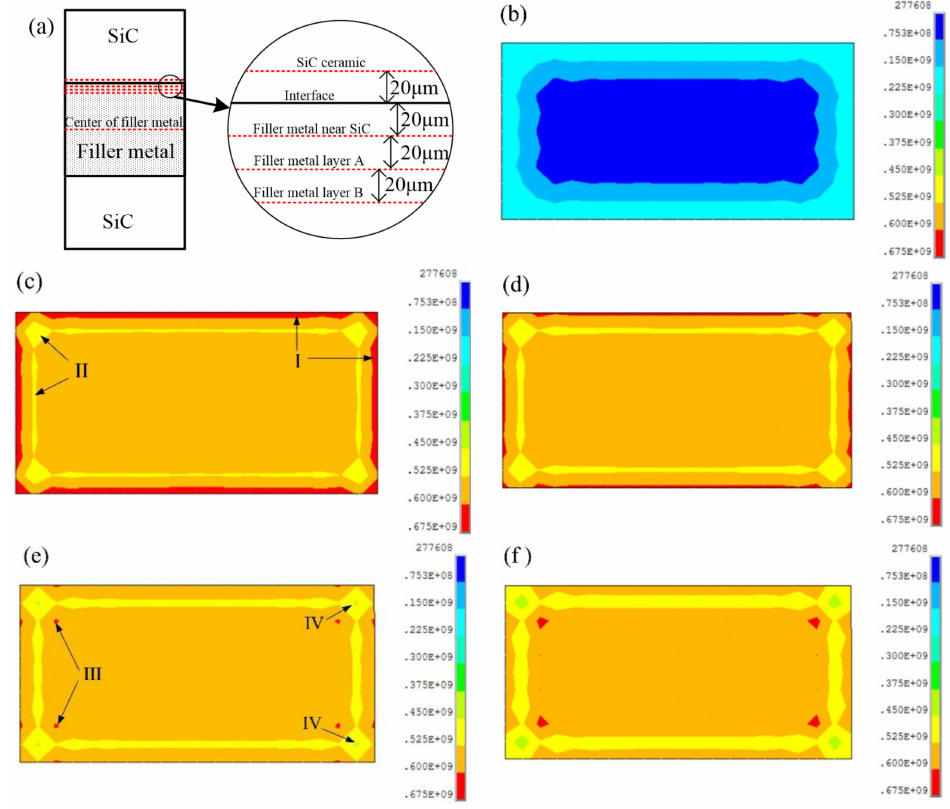
Figure 3. Von Mises stress of the di ff erent regions of the SiC ceramic joints at 1200 ◦ C: ( a ) schematic diagram of brazing joint slice, ( b ) SiC ceramic side, ( c ) filler metal near SiC ceramic, ( d ) filler metal layer A, ( e ) filler metal layer B, ( f ) center of the filler